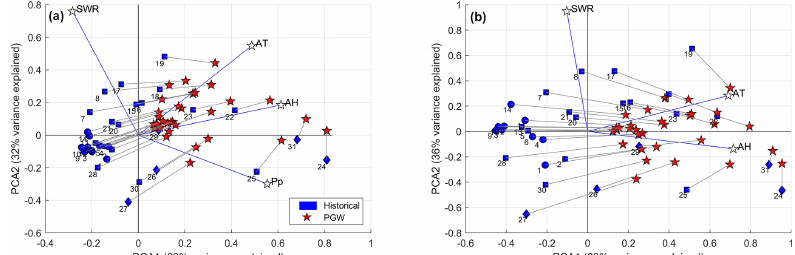
Figure A6. (a) Principal component analysis for historical precipitation (Pp), air temperature (AT), absolute humidity (AH) and shortwave radiation (SWR) at each watershed and the changes associated with the pseudo global warming as simulated by WRF. Panel (b) shows the same analysis but excluding precipitation from the analysis. Blue symbols (circle, square, and diamond) associated with historical values represent the mean annual percentage of clear-sky snowmelt days, where sunny sites have > 90% clear-sky snowmelt days, partly cloudy have between 70% and 90%, and cloudy have < 70%; clear-sky snowmelt days are defined as those with more than 80% of the potential clear-sky solar radiation. We make no inference about the cloudiness condition during snowmelt days under the RCP8.5 pseudo global warming scenario, and thus, we use a five-point star (in red) for the future scenario. Numbers next to blue symbols represent the gauge IDs as presented in Table 2.